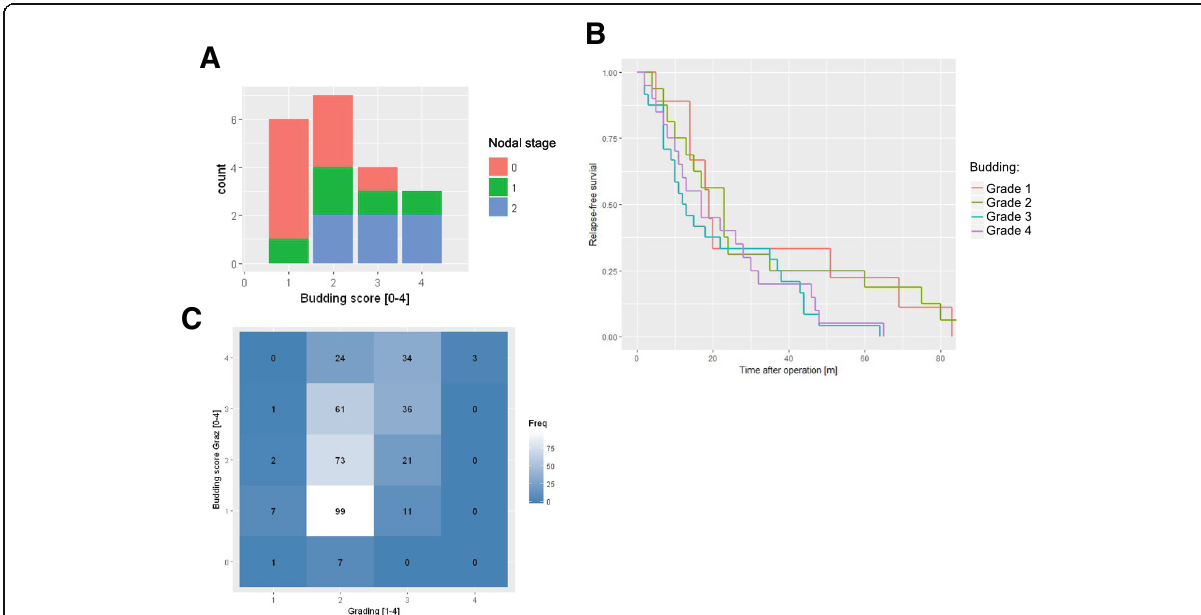
Fig. 1 Correlation of the budding score to clinical data. The externally provided budding score of 328 cases showed a correlation to the patient ’ s nodal status ( a ) and to the regression-free survival ( b ), as previously published by [9, 10]. Furthermore, within the database there is also a significant correlation between the budding score (grades 1 to 4 with the intervals [0 – 5], [5 – 17], [17 – 20] and [20- ∞ ] to stratify the absolute number of tumor buds [9]) and the morphology-based tumor grading (Grade 1 – 4) ( c )